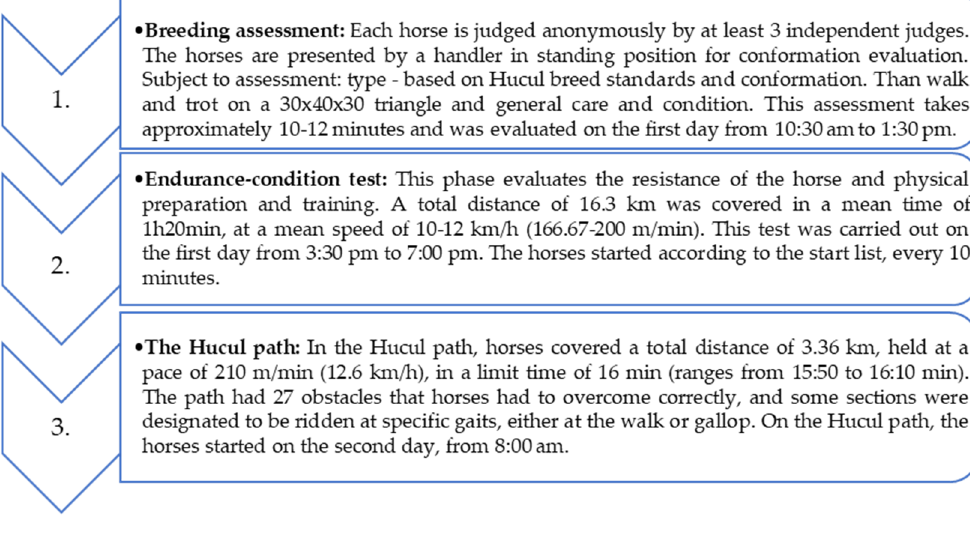
Figure 1. A diagram showing the order of competition during the Polish Championships for Hucul Horse in 2019.